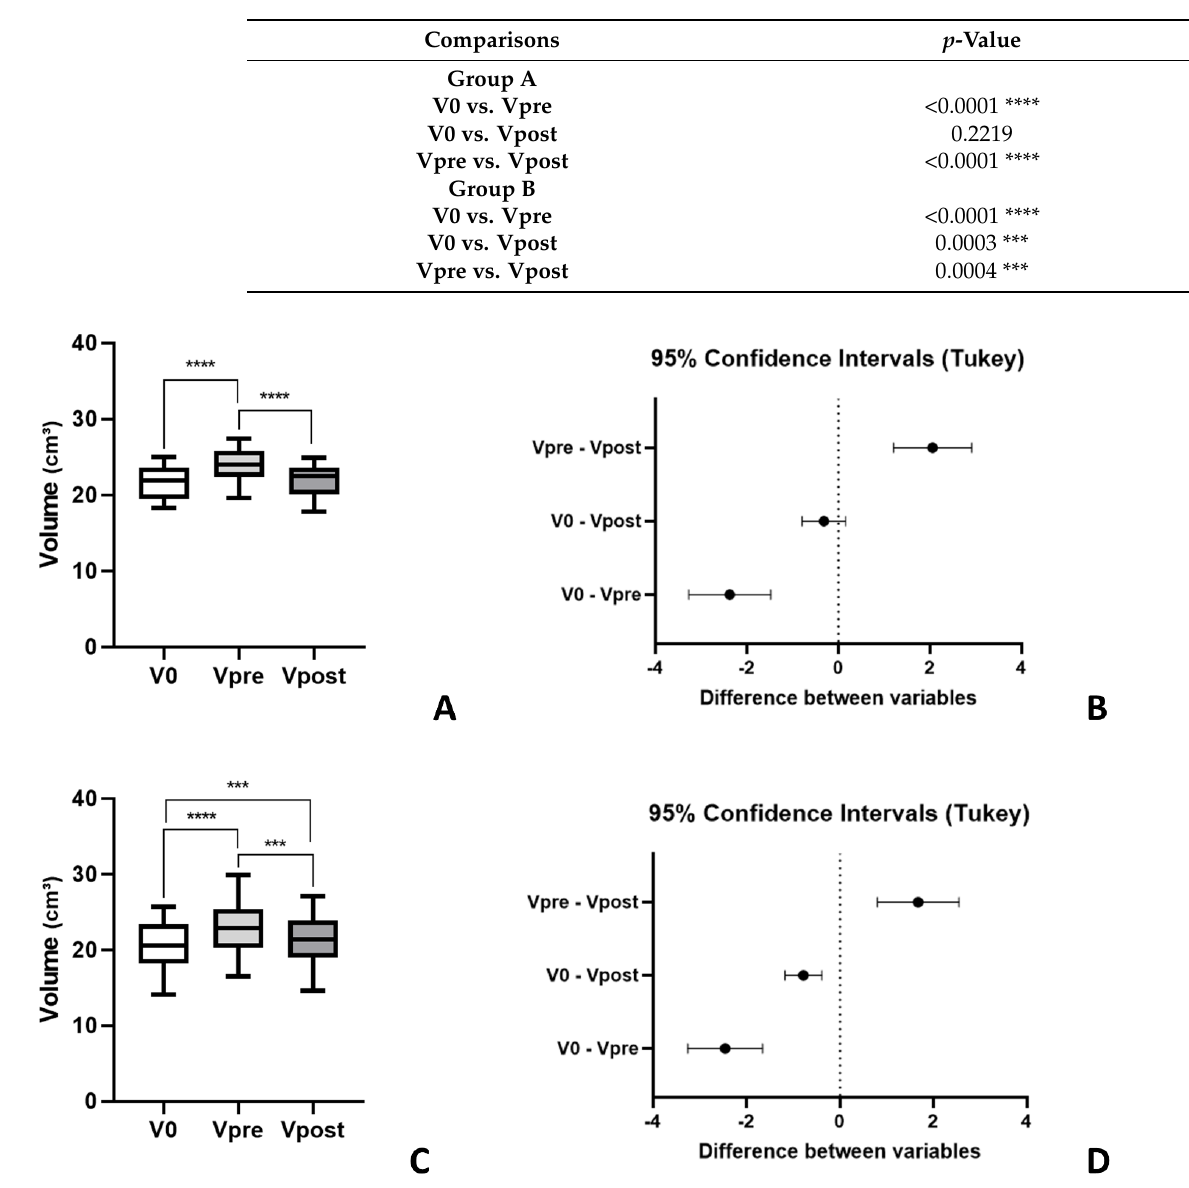
Table 3. Surgical outcomes: comparison of variables within each group. (V0: orbital volume of the normal side; Vpre: preoperative orbital volume of the lesion side; Vpost: postoperative orbital volume of the lesion side). **** p -value is significant at the 0.0001 level. *** p -value is significant at the 0.001 level.